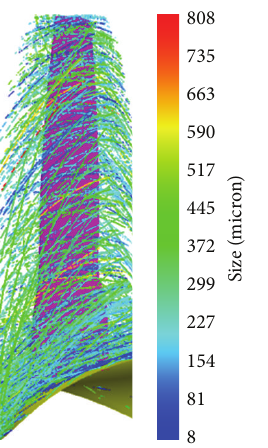
Figure9:Sampleofsand(0–1000 𝜇 m)particlestrajectoriescrossing the rotor